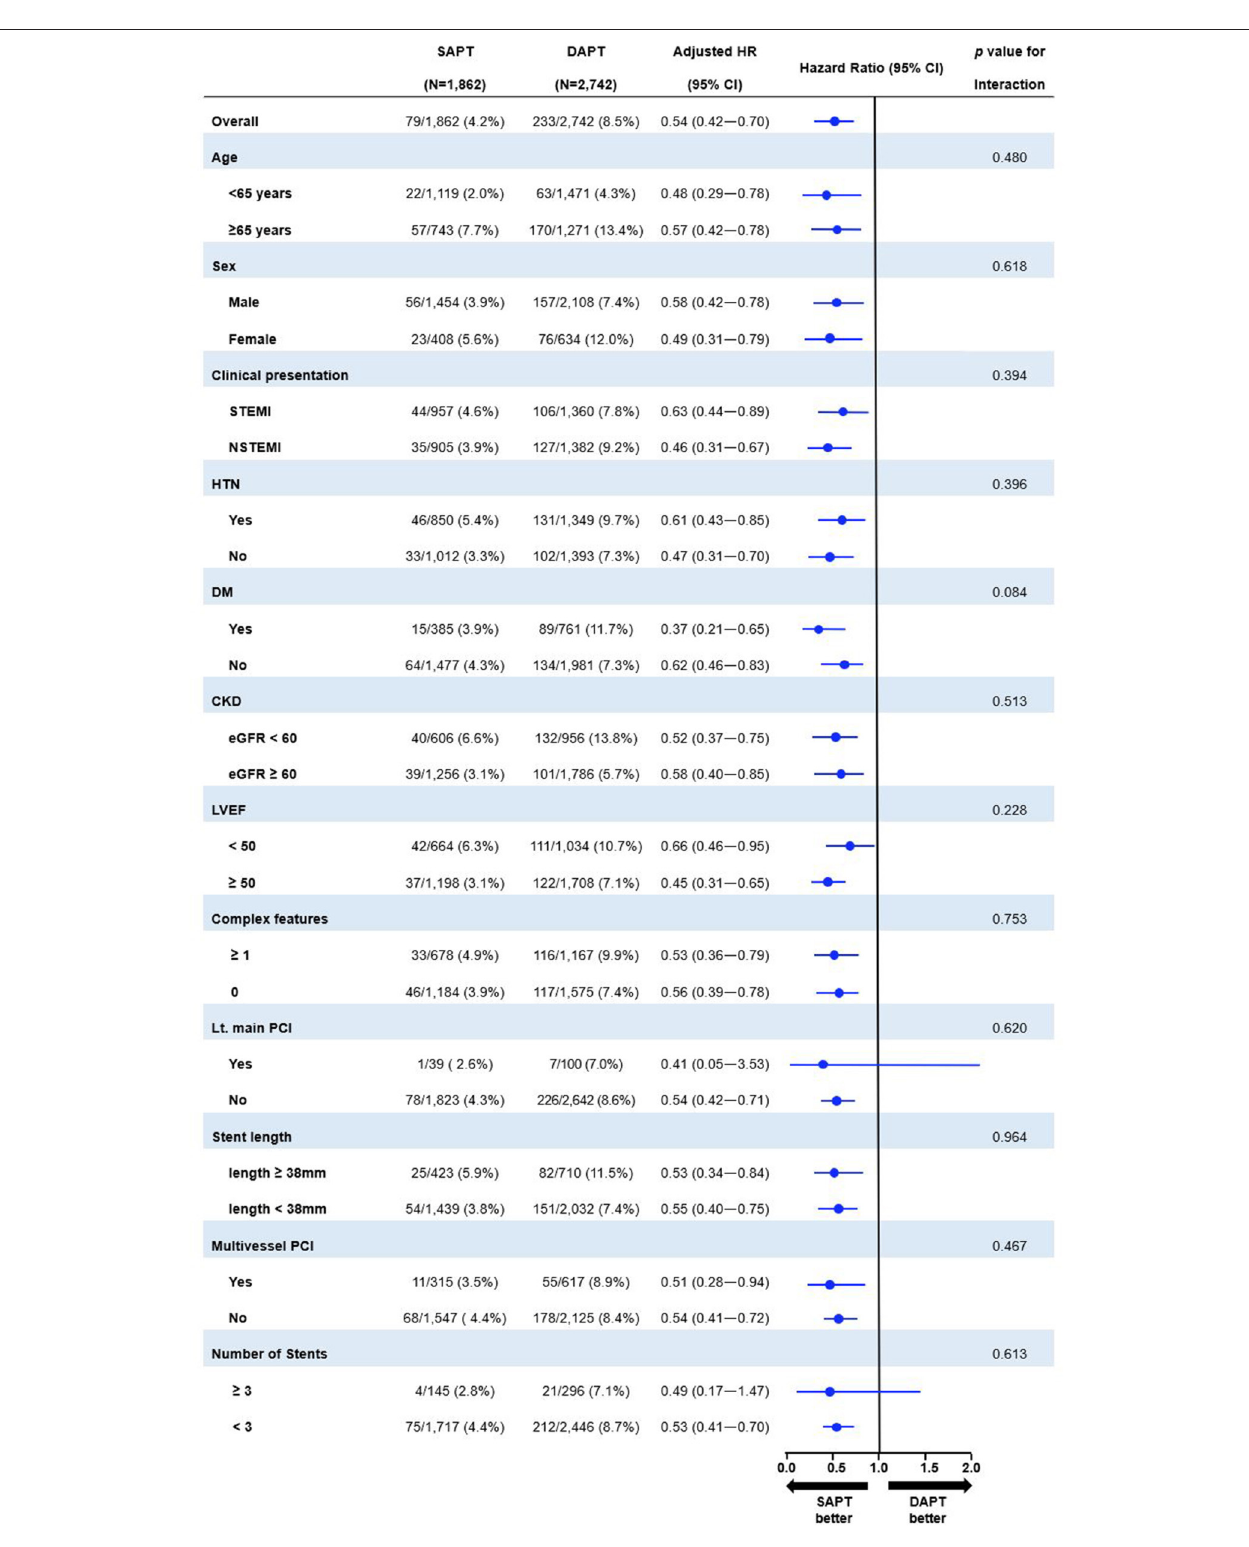
Frontiers in Cardiovascular Medicine |